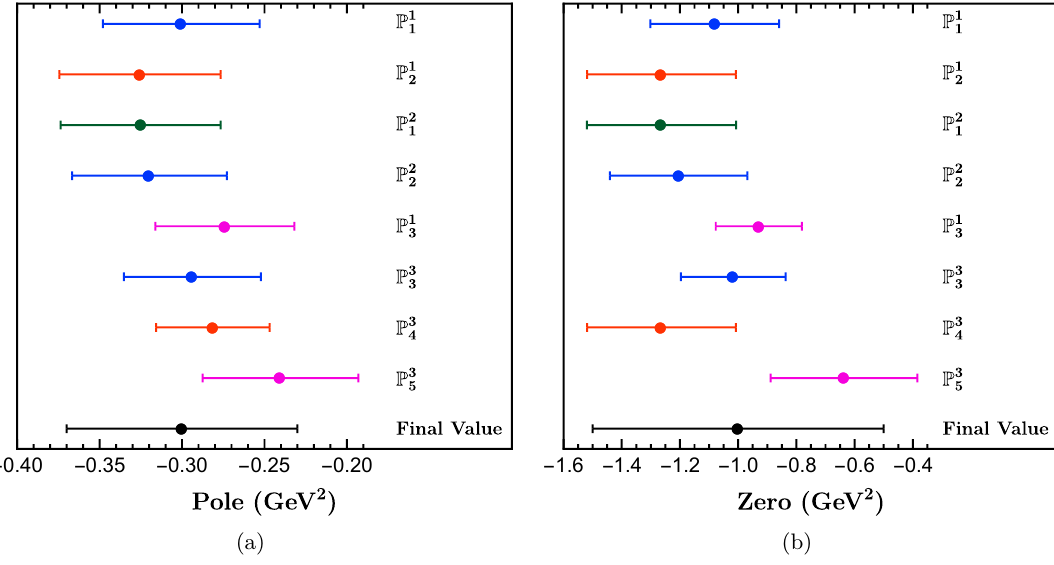
Figure 7 . Location of the (a) pole and (b) zero from the partial Padé approximants, fitted to the Landau-gauge ghost-propagator lattice data. Results from approximants belonging to the same sequence are shown in the same color [blue for P N ( p 2 ) , orange for P N ( p 2 ) and pink for P N ( p 2 ) ]. N N +1 N +2 Our final values are shown in black at the bottom of each plot. As before, in this plot we add in quadrature the statistical and systematic errors. The pole followed by a zero points towards the presence of a branch cut along the negative real axis of p 2 . (See discussion in the